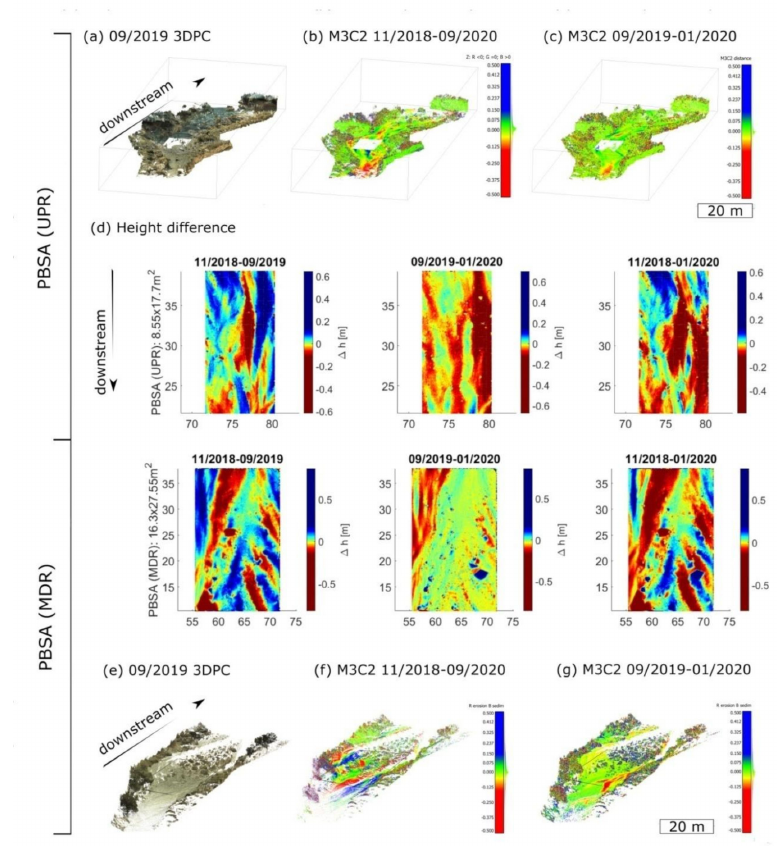
Figure 8. ( a ) View of 3DPC captured in 2019; ( b , c ) M3C2 comparison of the 2018–2019 and 2019–2020 3DPCs, respectively; ( d ) height di ff erence between 2018, 2019, and 2020 in the Upper and Middle PBSA; ( e ) view of 3DPC captured in 2019; ( f , g ) M3C2 comparison of the 2018–2019 and 2019–2020 3DPCs